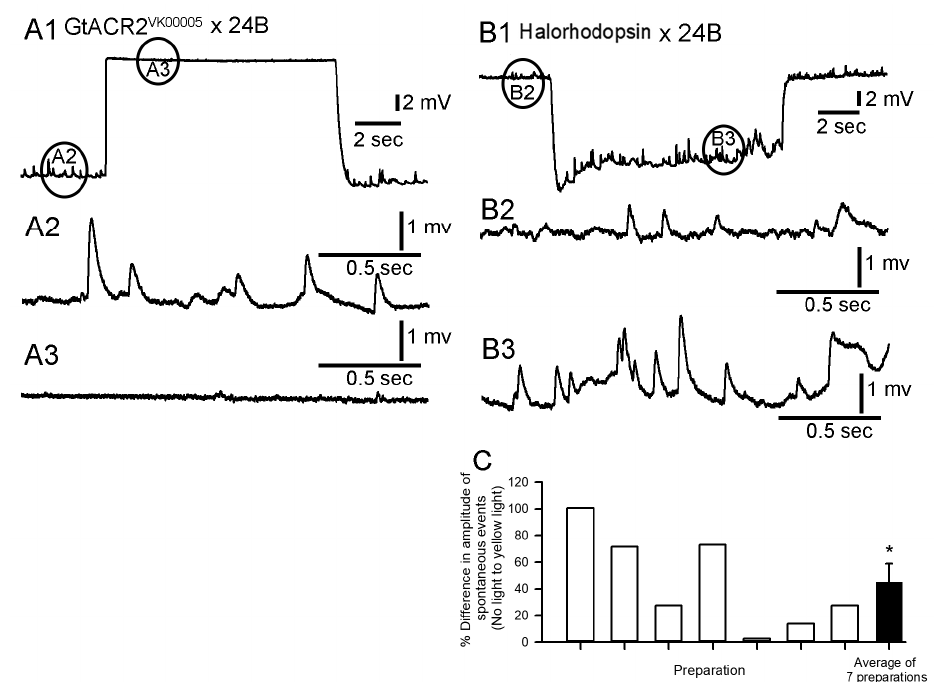
Figure 7. Amplitudes of spontaneous quantal events before and during light pulses. ( A1 ) The spontaneous events are readily observed before the light pulse ( A2 ) for a GtACR2 VK00005 × 24B larva, but during the depolarization induced by blue light ( A3 ) are greatly reduced. ( B1 ) The halorhodopsin (eNpHR) × 24B-expressing line shows quantal synaptic events before ( B2 ) and during ( B3 ) the hyperpolarizing event induce by yellow light. ( C ) The percent difference in the mean amplitude of spontaneous quantal events before and during the hyperpolarizing light pulse for the seven halorhodopsin (eNpHR) × 24B-expressing preparations (Two tailed paired T-test, p = 0.014). The circles in A1 and B1 indicate where the graphs were enlarged for representative activity before (A2, B2) and during (A3, B3) the light pluses.